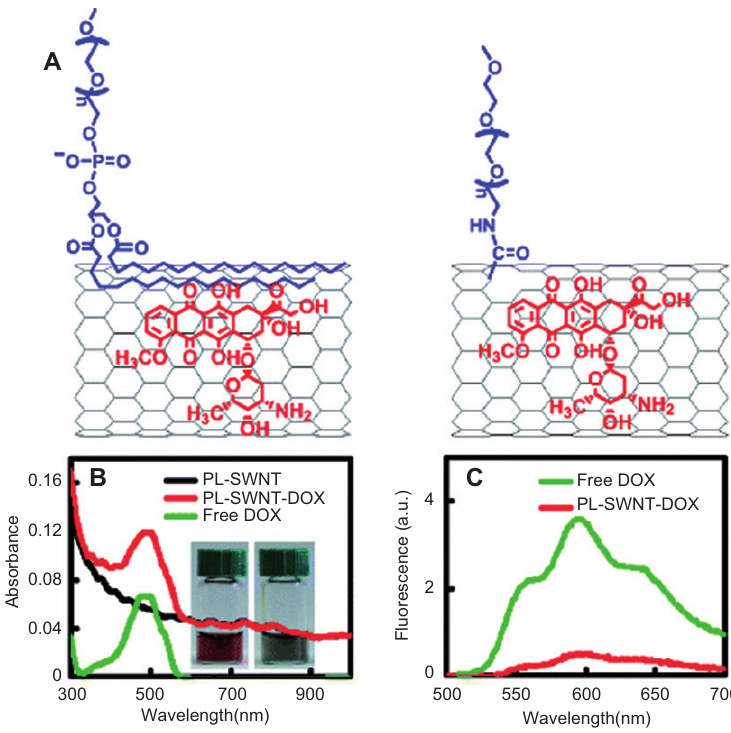
Figure 4 Supramolecular assembly of molecules on functionalized CNTs [19] . Reprinted with permission from Ref. [19] . Copyright (2007) American Chemical